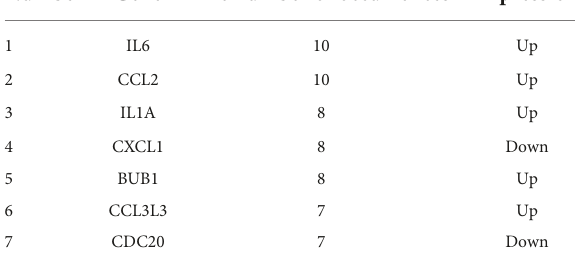
TABLE 3 Top ten genes in the 12 statistical methods.